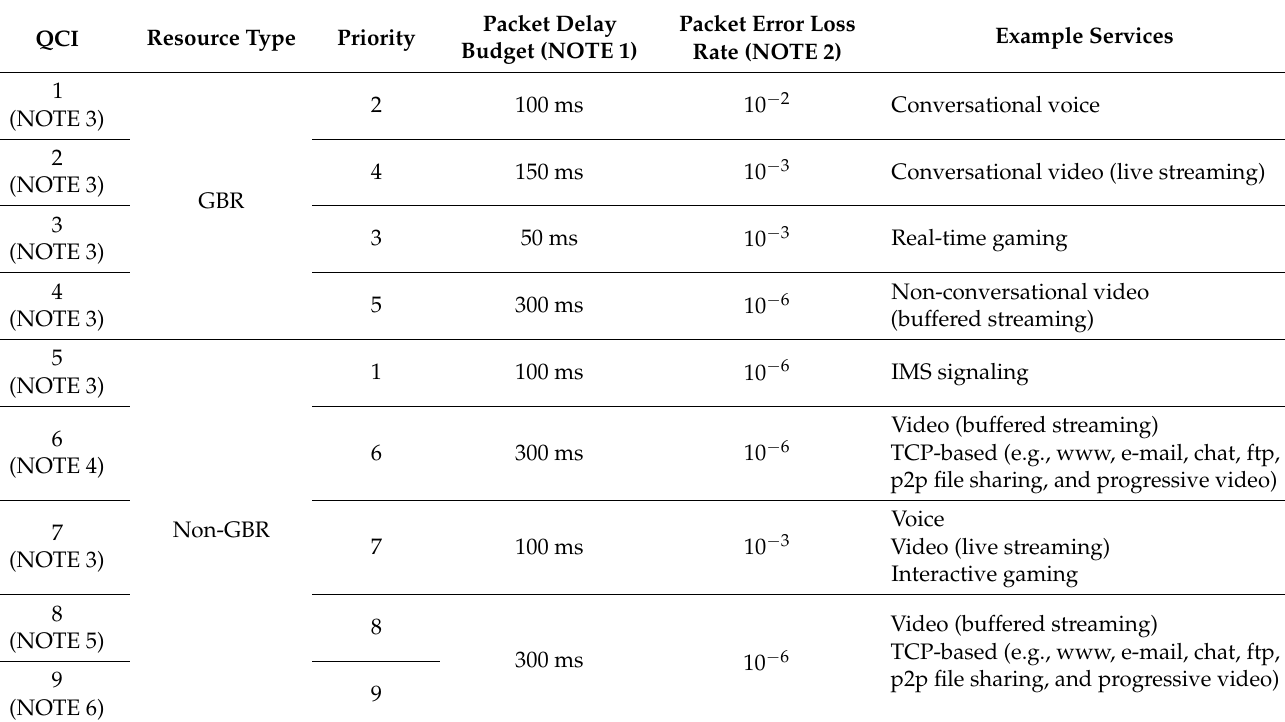
Table 3. QCI specifications for LTE [29]. (© 2022 - 3GPP™ deliverables and material are the property of ARIB, ATIS, CCSA, ETSI, TSDSI, TTA and TTC who jointly own the copyright in them. They may be subject to further modifications and are therefore provided to you "as is" for information purposes only. Further use is strictly